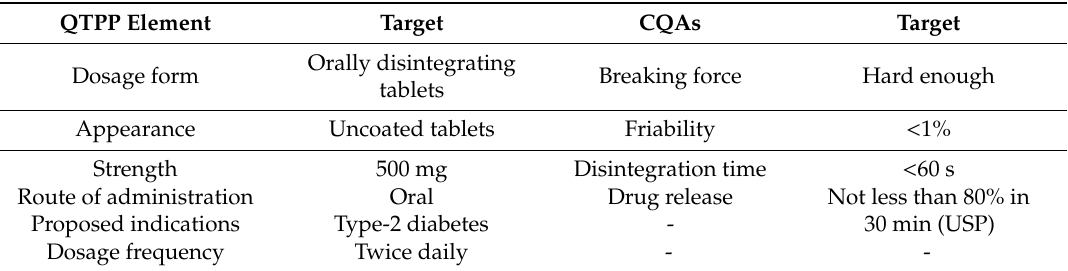
Table 1. Quality target product profile (QTPP) and critical quality attributes (CQAs) of metformin fast orally disintegrating tablets. USP, United States